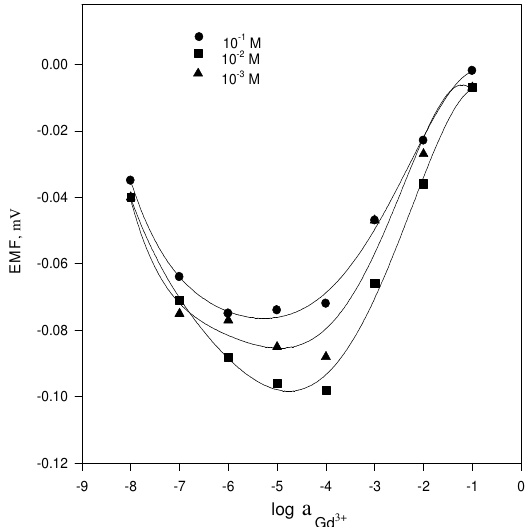
Figure 1(c). Curves for Gd(III) selective electrode (60% membrane) based on ZrWP in epoxy resin and also the effect of internal solution